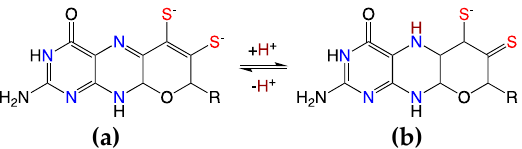
Figure 8. Oxidized PDT ligands: dihydropyranopterin ( a ) and protonated dihydropyranopterin ( b ) yielding the thiol/thione.